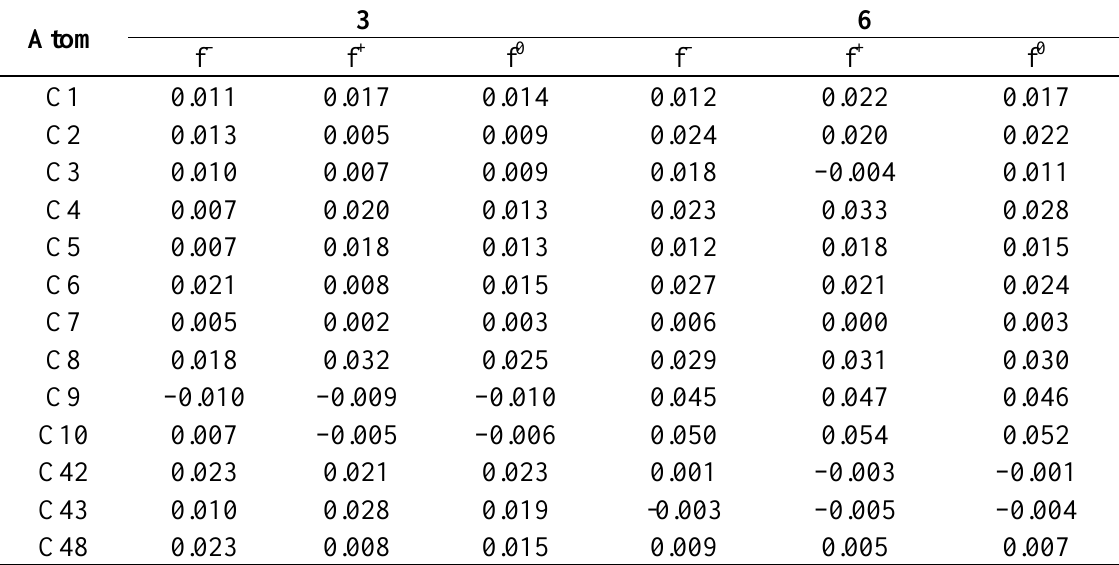
Table 5. Fukui indexes f + , f – and f 0 for selected atoms. (For notation refer to compound 3 ).